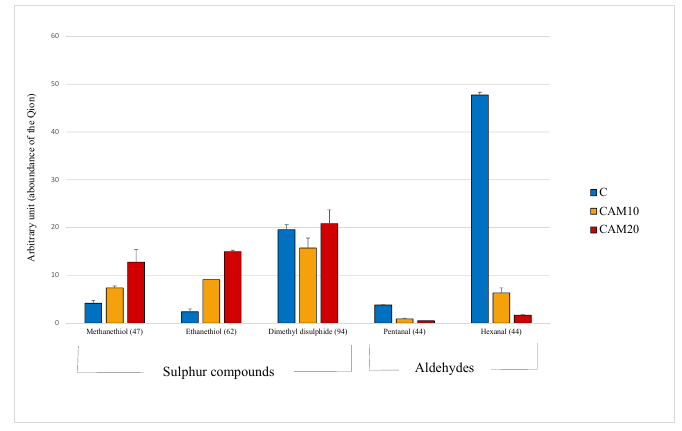
Figure 1. Volatile compounds recognized in the Control and camelina diets (CAM10 and CAM20). Data expressed as arbitrary units refer to the peak area of the Quant ion (in brackets).